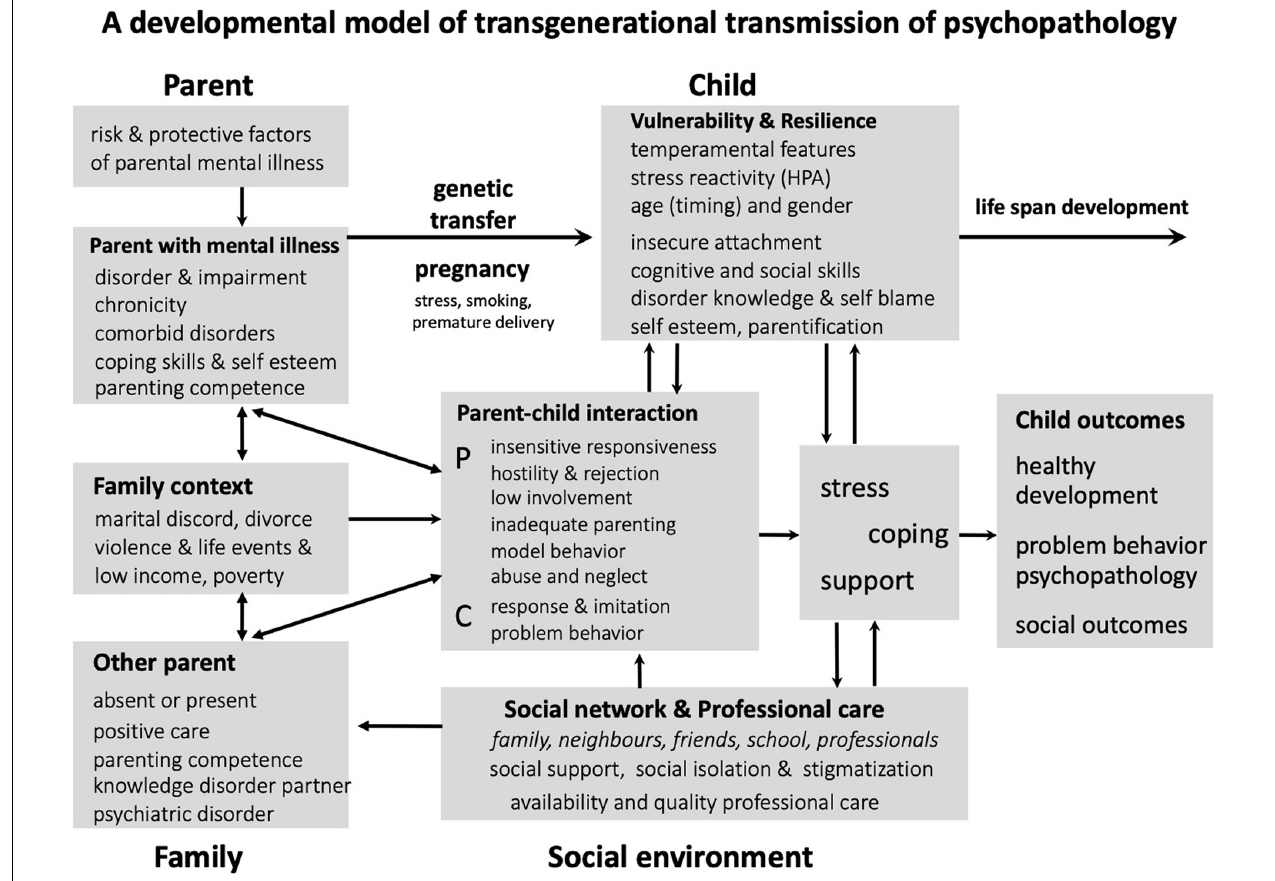
FIGURE 1 | Transmission mechanisms and factors in families with parental mental disorders (Hosman et al.,